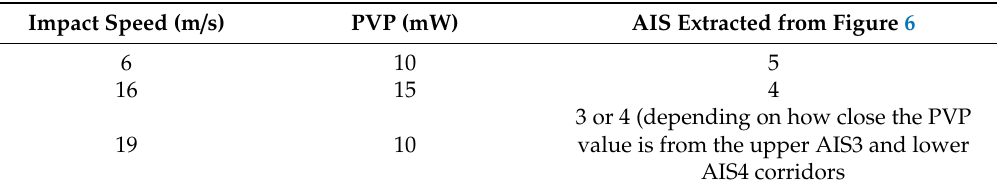
Table 3. Hypothetical scenarios extracted from Figure